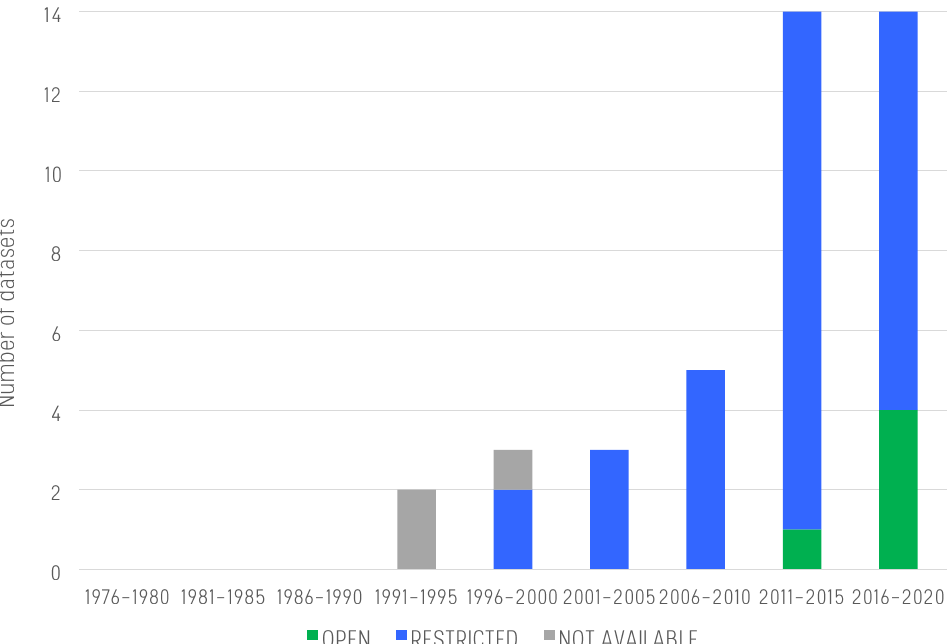
Figure 7. End use scale dataset count and accessibility over